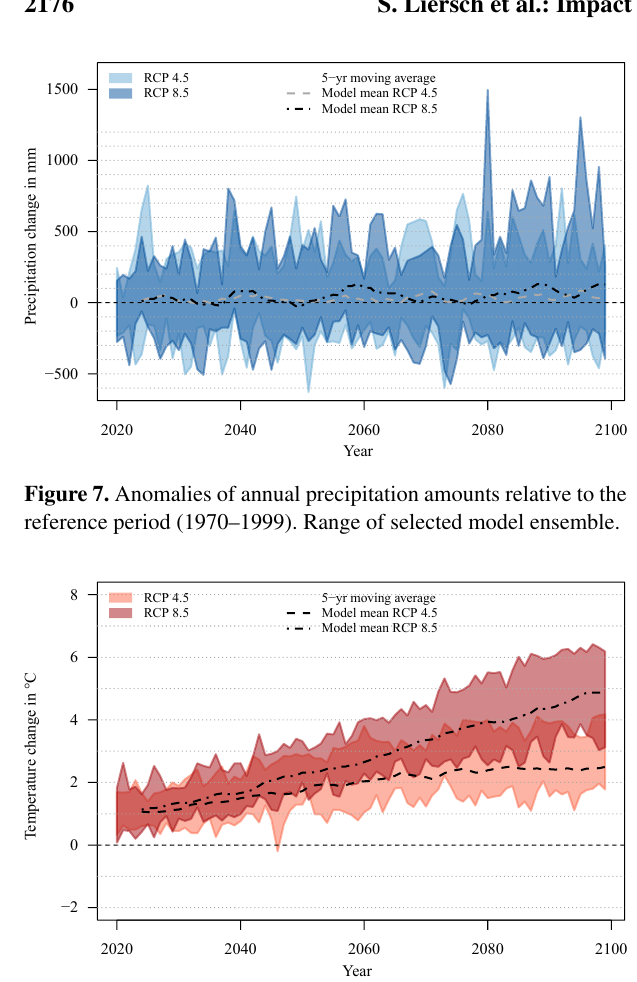
Figure 8. Anomalies of average annual mean air temperature rela- tive to the reference period (1970–1999). Range of selected model ensemble.